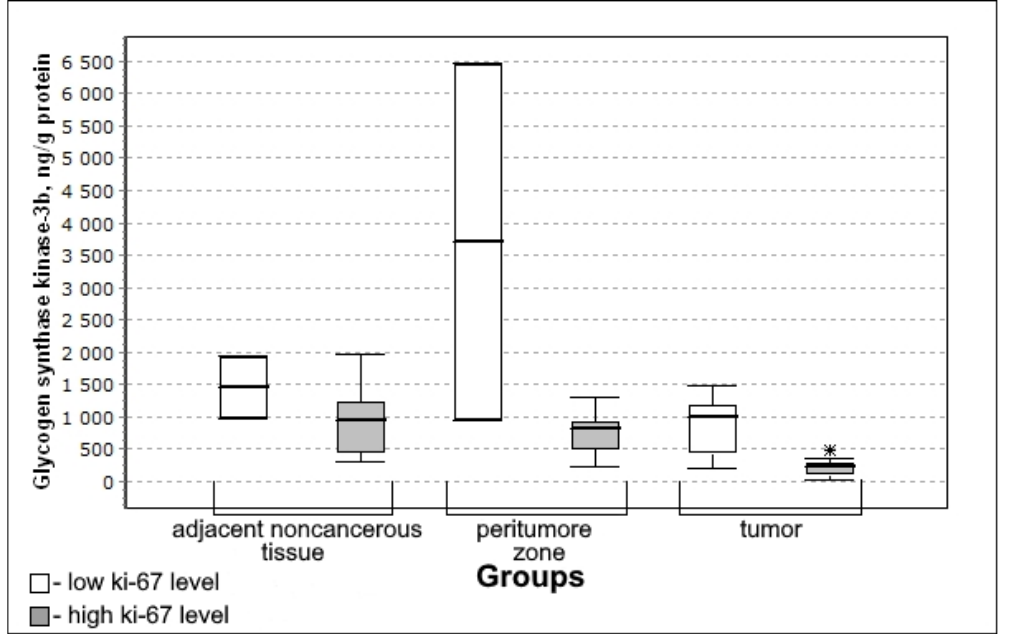
Figure 6. Medians and interquartile ranges (IQR) of the content of glycogen synthase kinase 3 β in glioma tissue depending on the magnitude of the mitotic index Ki-67 (low Ki-67 n = 7; high Ki-67 n = 13). Statistics are reported * p < 0.05.